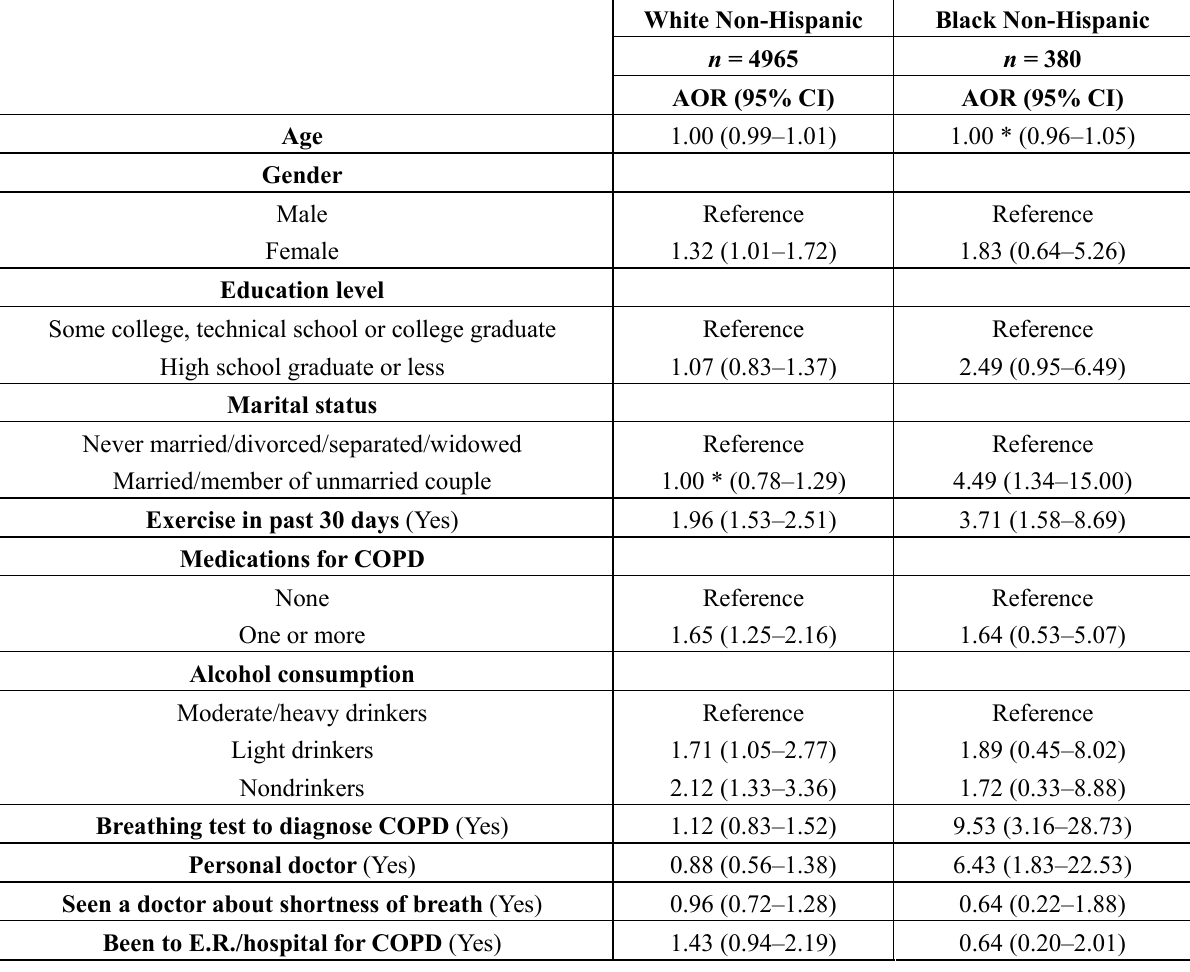
Table 2. Adjusted weighted prevalence odds ratios and 95% confidence intervals for making a quit attempt in the past 12 months among current smokers with COPD in the 2011 BRFSS, n =